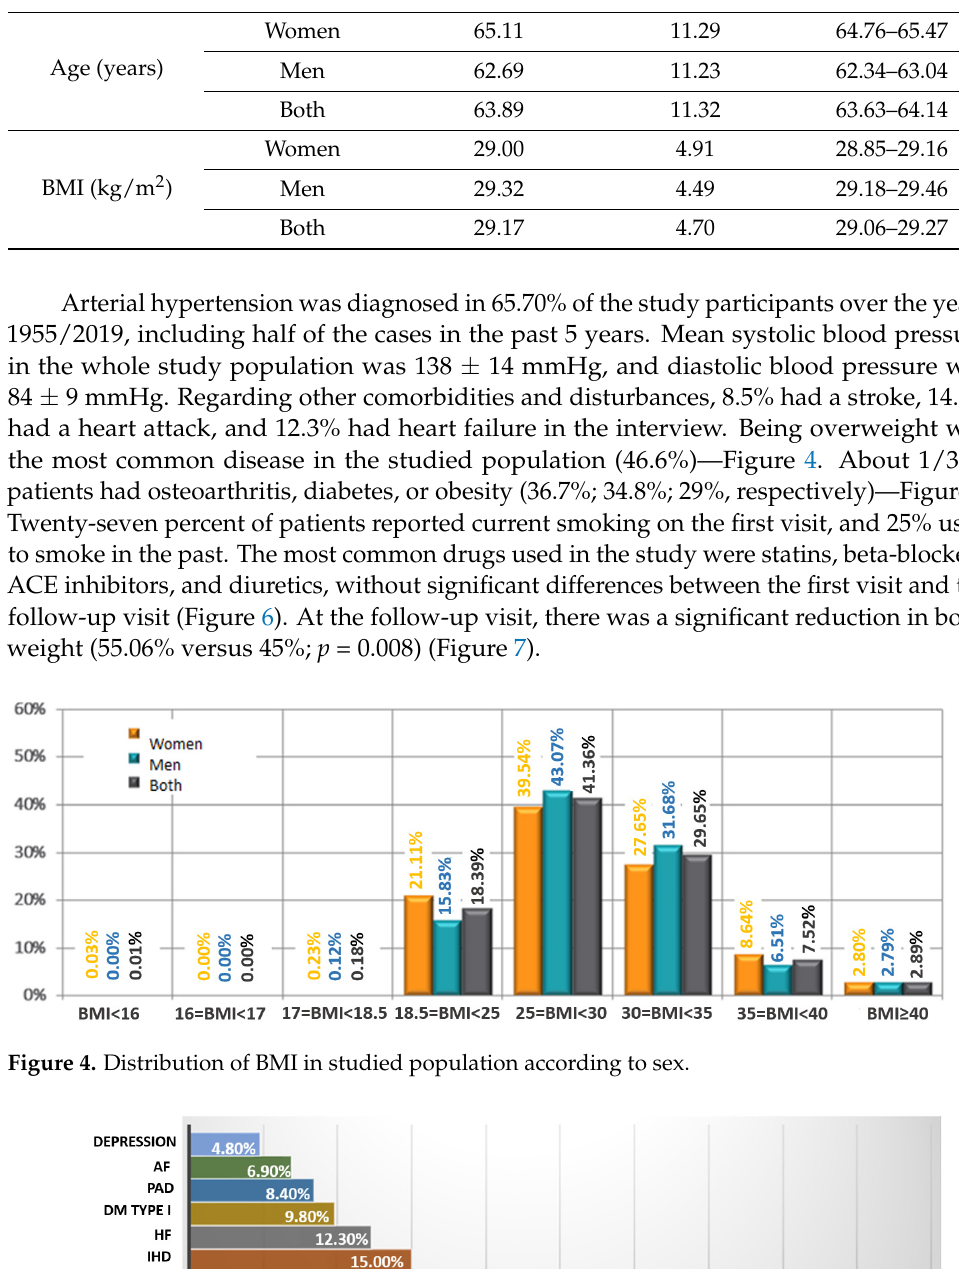
Table 1. Characteristics of age and BMI in studied population.